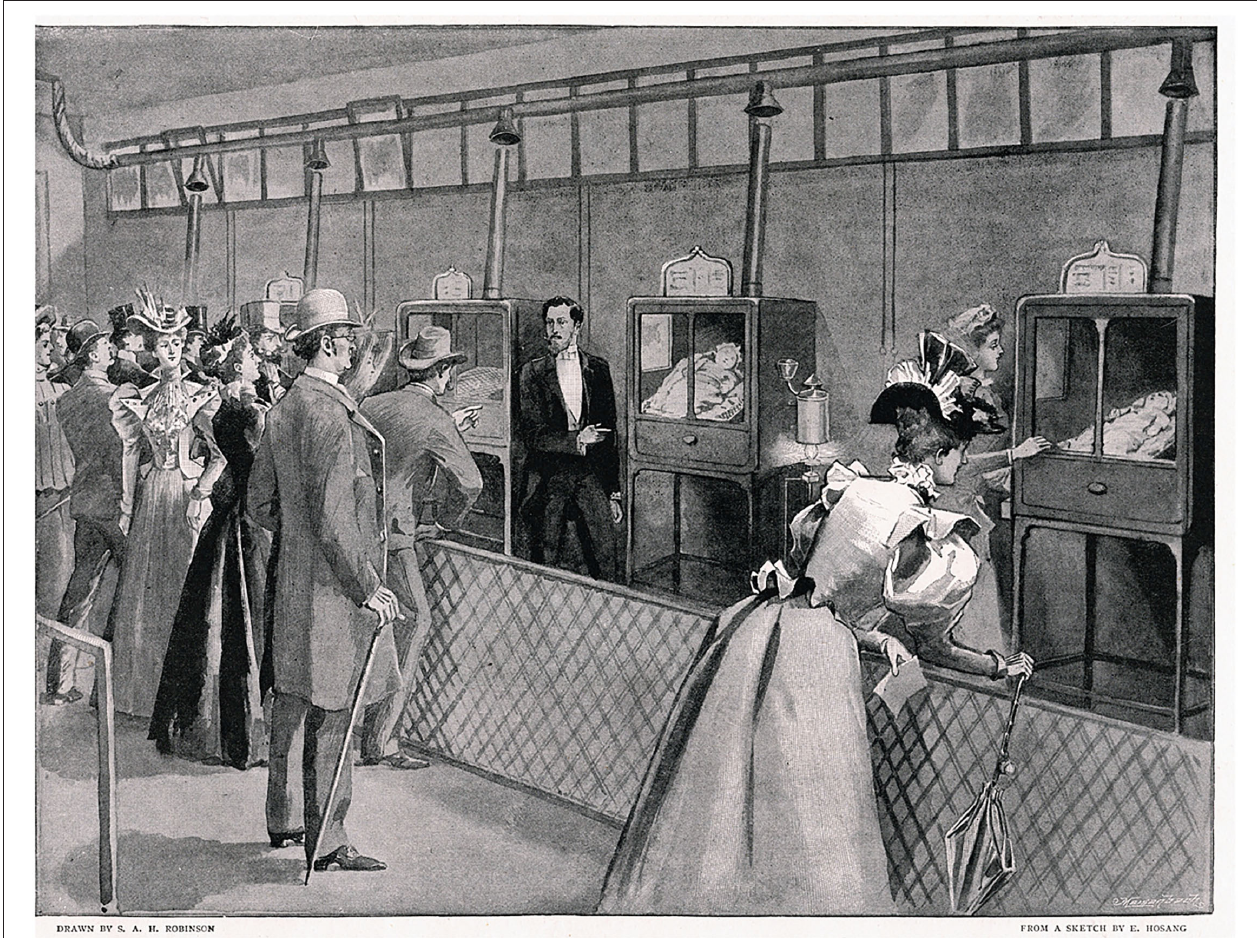
FIGURE 2 | “An Artificial Foster Mother: Baby Incubators at the Berlin Exposition”. Display of Lion Incubators in 1896. Retrieved from: The Graphic 1896; 54:461; https://www.epoch-magazine.com/post/mothers-and-machines-on-the-midway-the-curious-case-of-baby-incubators.